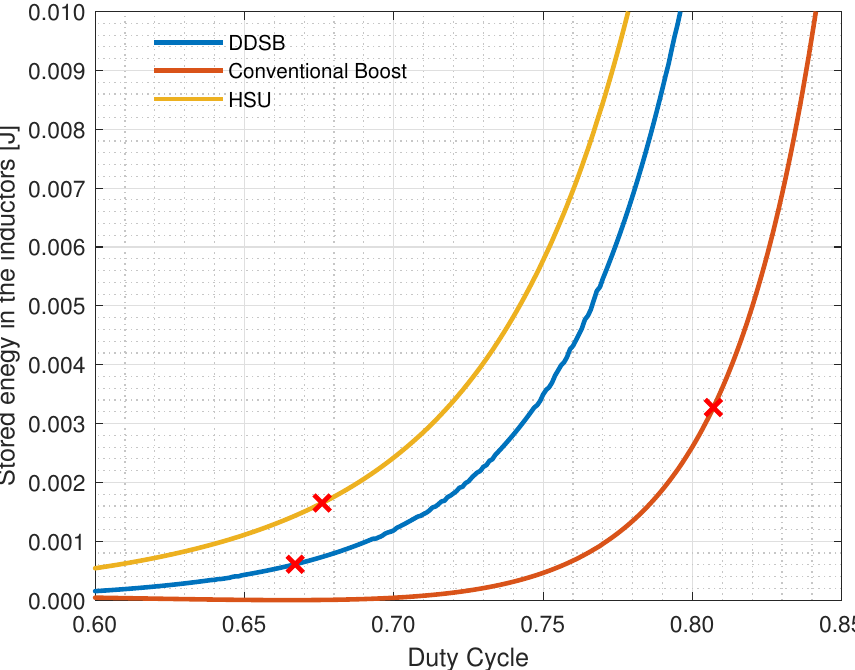
Figure 9. Stored energy in the inductors of the conventional boost, HSU, and DDSB power converters with respect to the duty cycle d .